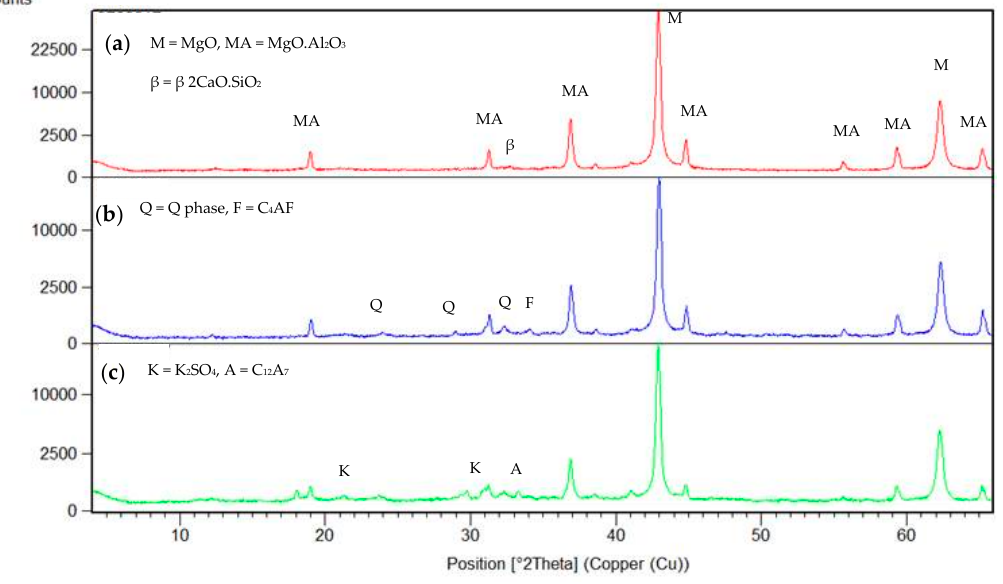
Figure 6. X-ray diffraction patterns of brick A. ( a ) Unused. ( b ) Hot face after contact coating test using cement raw meal as received. ( c ) Hot face after contact coating test using modified cement raw meal.